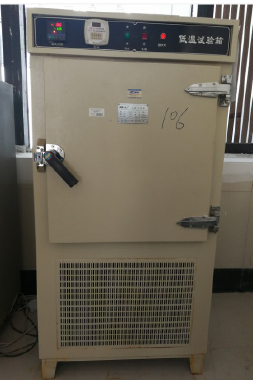
Figure 2. The freeze–thaw equipment.